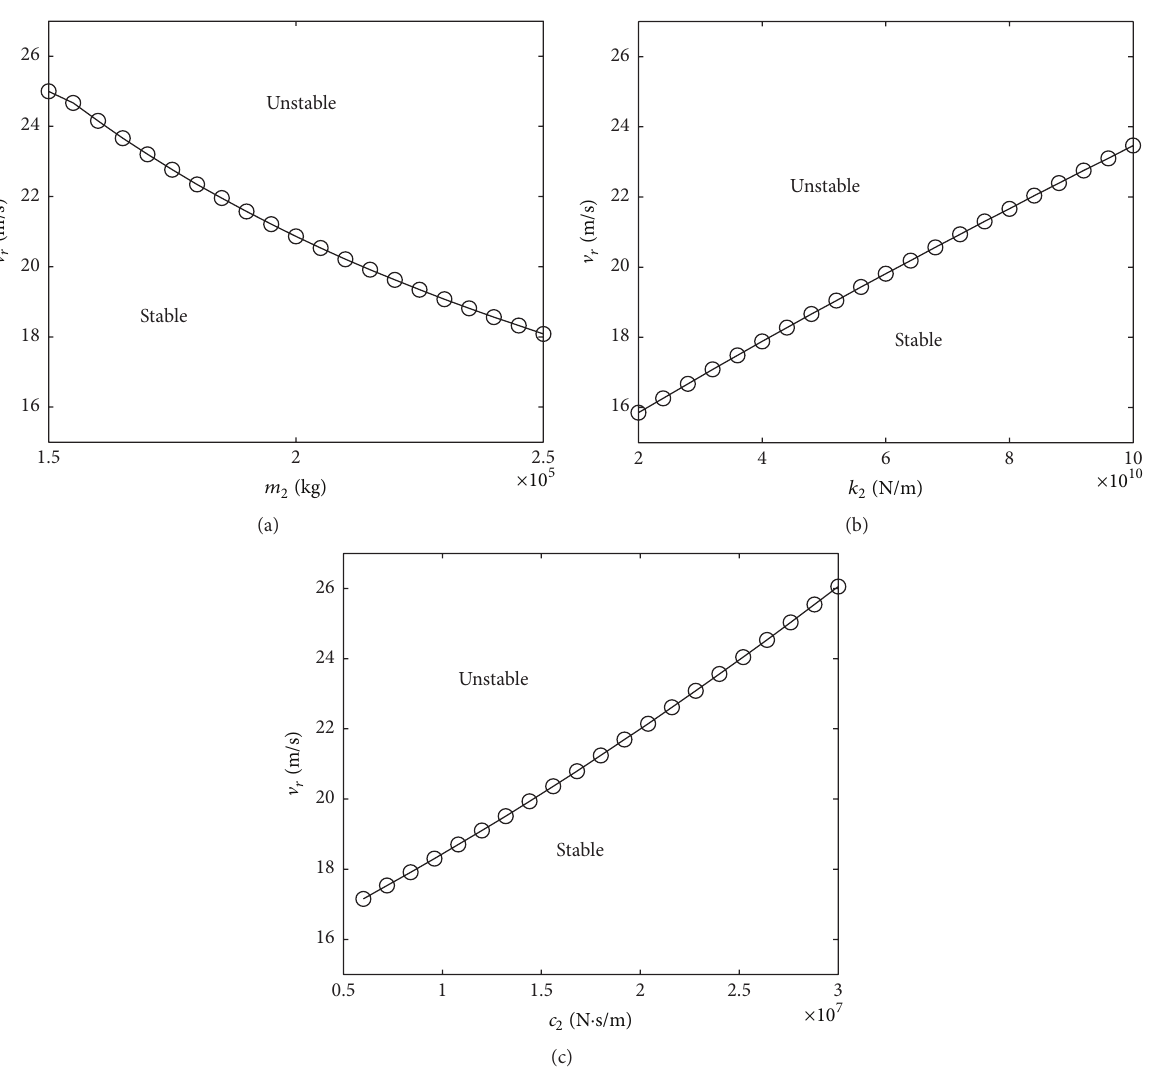
Figure 17: Influences of vertical structural parameters on system